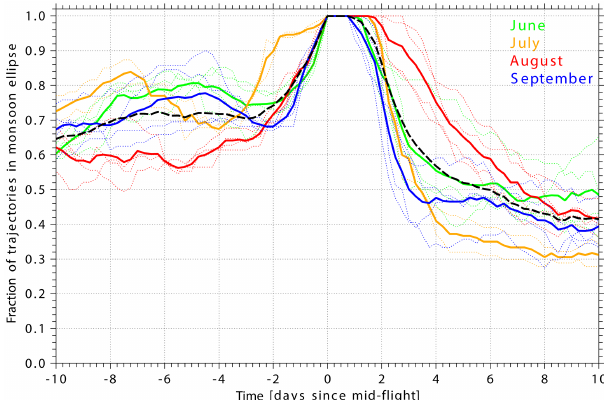
Figure 16. Monsoon leak rates for all flights between June and September 2008. Shown is the fraction of the backward and forward trajectories which started inside the monsoon ellipse ( t = 0) and are inside the monsoon ellipse at the given time in days before and af- ter the aircraft was inside the monsoon ellipse (see Sect. 3.3.3). The solid coloured lines are monthly means with the results from the single flights indicated by dotted lines. Colours indicate the months. The dashed black line shows the mean leak rate averaged over all